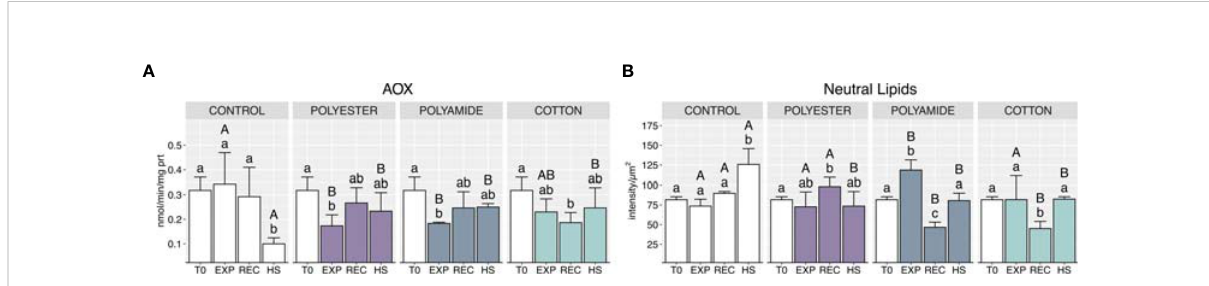
FIGURE 6 Acyl-CoA oxidase activity (A) and neutral lipids content (B) in control and polyester, polyamide or cotton-exposed mussels measured at T0 and at the end of each experimental phase (EXP, end of MFs-exposure; REC, recovery after MFs-exposure; HS, heat-stress after the MFs-exposure). Upper case letters highlight differences among treatments within the same experimental phase; lower case letters highlight differences among different experimental phases of the same treatment. Values are given as mean ± SD (n=4).